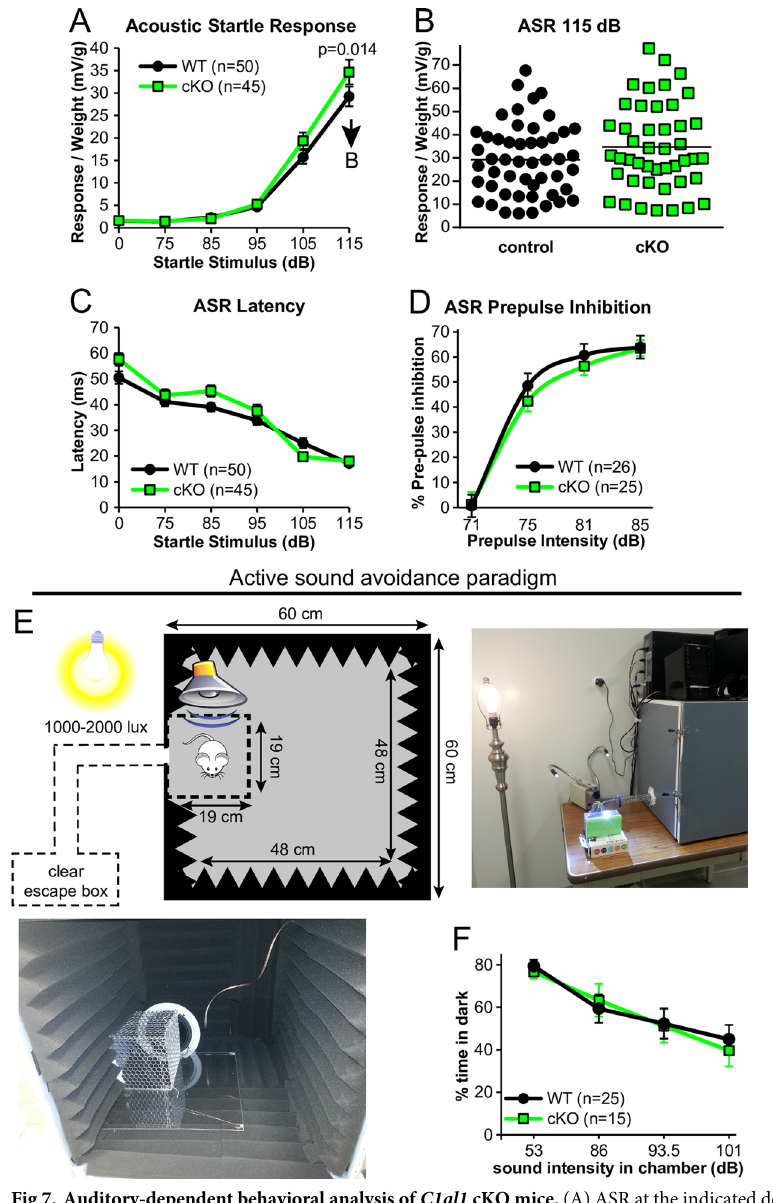
Fig 7. Auditory-dependent behavioral analysis of C1ql1 cKO mice. (A) ASR at the indicated decibel levels. Mice were 7–10 weeks old. Statistical test: repeated measures 2-way ANOVA with Bonferroni’s post-hoc test. (B) The data presented for the 115 dB SPL sound level in panel A is reproduced here, but displaying each data point. Each point is 1 mouse. (C) Latency of ASR at the indicated decibel levels. (D) Pre-pulse inhibition of the ASR (consistent 115 dB SPL startle) at the indicated pre-pulse decibel levels. (E) Construction of a custom-built behavior apparatus to test active sound avoidance in mice. (F) Results from the indicated genotypes in sound avoidance behavior at varying sound intensity levels. Mice were 10–11 weeks